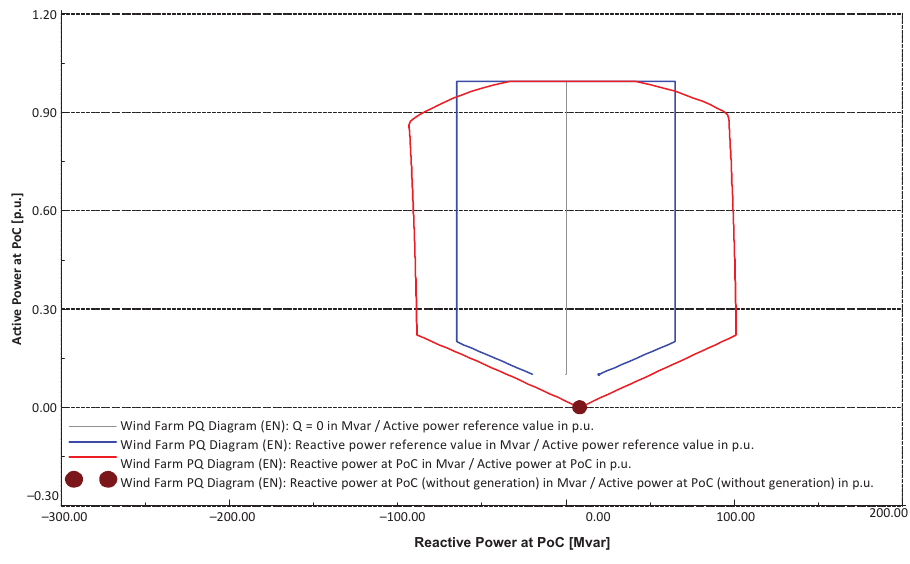
Figure 7. Reactive power capability of wind park without PPC. The modified reactive power capability of the wind park by park controller in accor- dance with the reference (blue color) is as shown in Figure 8. The capacitor bank is switched on by PPC in order to meet the reactive power requirement. The park controller present in the wind farm switches ON the capacitor bank of 25.2 MVar in two steps depending on the reactive power requirement at the PCC. It can be observed from the DIgSILENT report that the capability is increased to 82.58 Mvar for underexcited and 83.14 Mvar for overexcited cases compared with the results obtained without park controller. As can be observed from Figure 8, the blue curve (requirement) is well within the red curve (capability of the wind park) for both underexcited (left side of origin) and overexcited (right side of origin) cases. The DIgSILENT output is given in Table 2. The PPC finds new active and reactive power set points, thereby operating the capacitor bank in order to meet the reactive power requirements. It can be seen from the results that there is a fair margin between capability and requirements, enabling the wind park to accommodate any future rise in reactive power requirement.